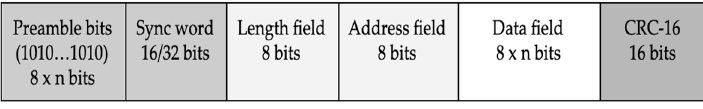
Figure 7. CC2500 radio transmission packet structure.